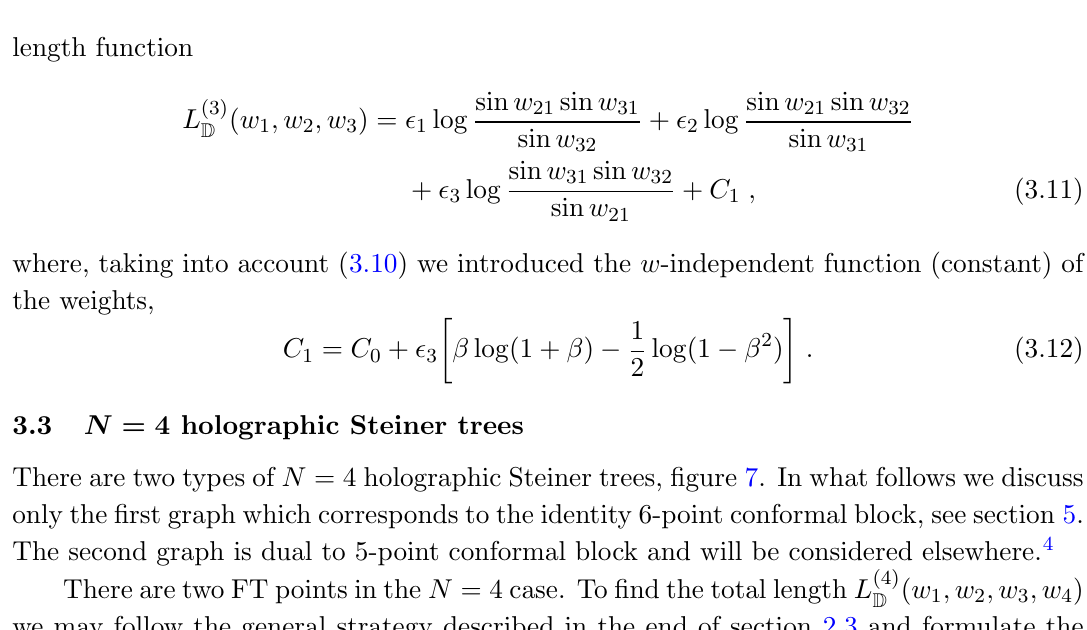
Figure 7 . i -th identity block: ˜ ✏ i = 0, the zeroth channel is shown in red.